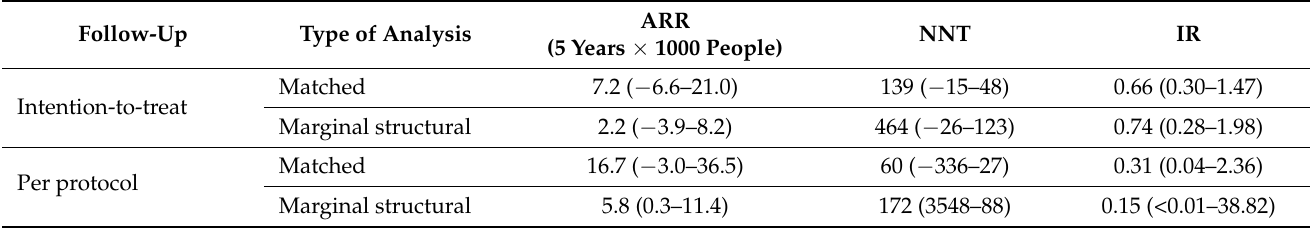
Table 4. Summary of the